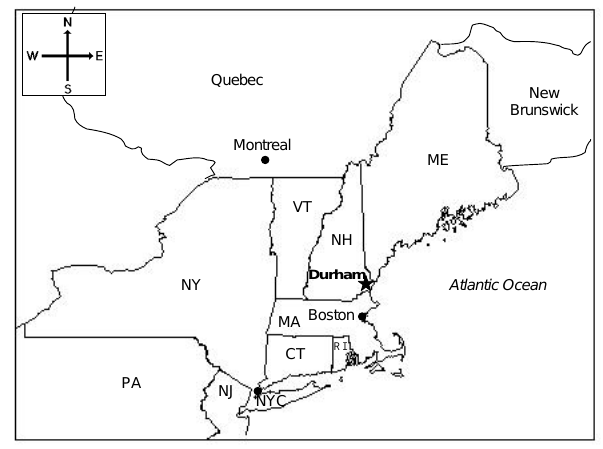
Fig. 1. Location of the UNH AIRMAP Atmospheric Observing Station at Thompson Farm in Durham, New